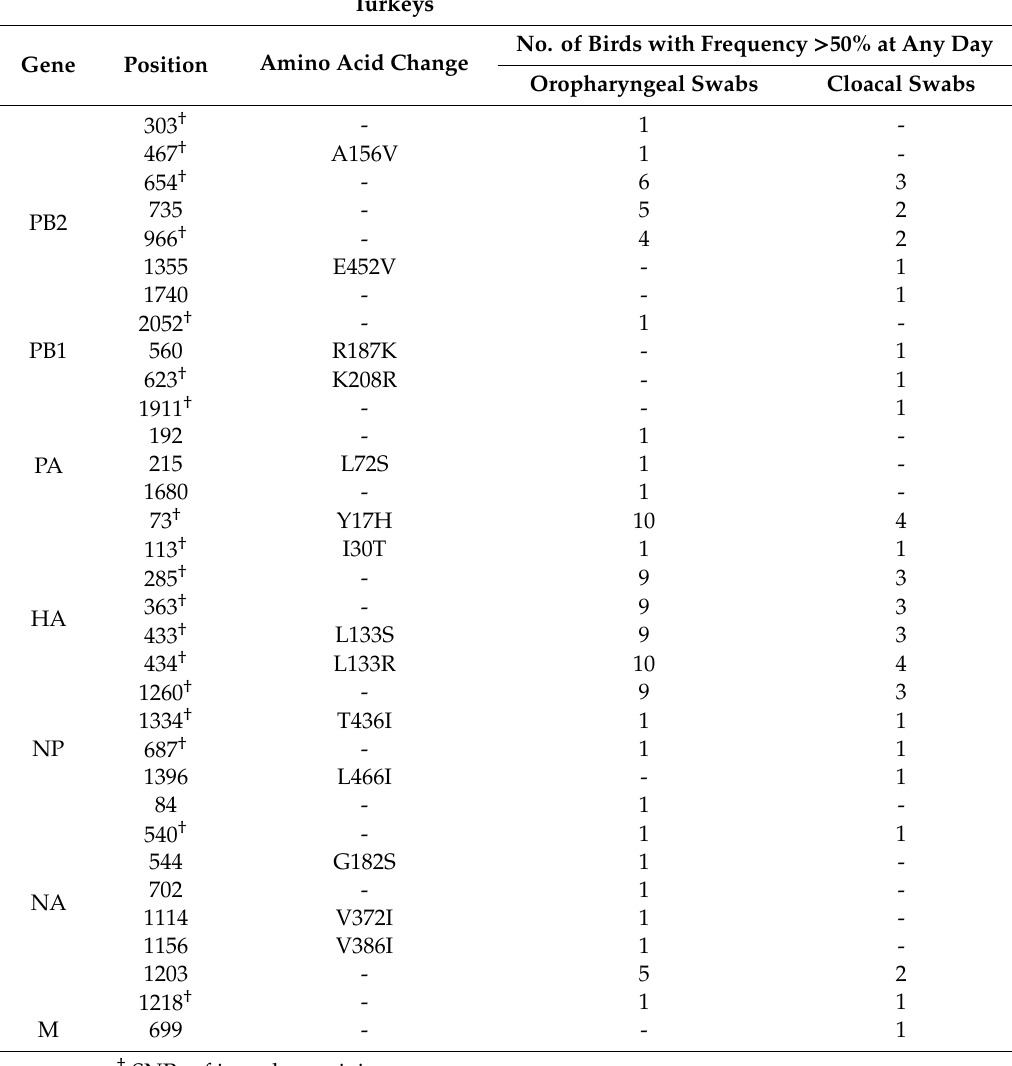
Table 3. Changes in the consensus sequences in samples collected from turkeys infected with A / turkey / Poland / 14 / 2013(H9N2).